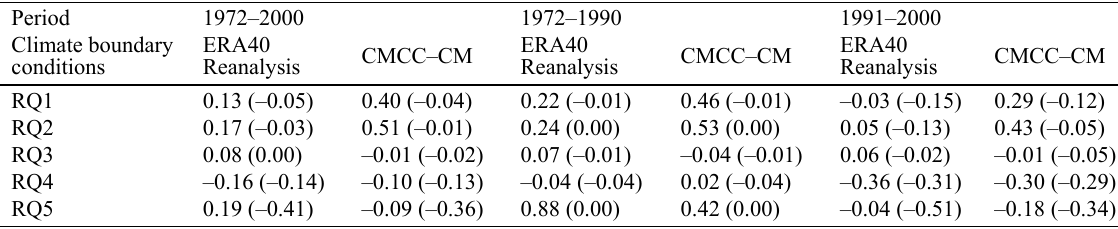
Fig. 2 Monthly average (a) areal precipitation and (b) discharge at Pontelagoscuro and (c) FDCs. In panel (c) only some of the points are indicated with the symbols. The simulations are labelled according to the climate data used to force them: observations, COSMO–CLM driven by ERA40 Reanalysis or COSMO–CLM driven by CMCC–CM. Table 1 Values of the RQ indices computed in the calibration (1972–1990), validation (1991–2000) and for the whole simulation period (1972–2000) for original discharge time series with respect to the simulation driven by the observed climate over the same periods. Values in brackets refer to corrected simulations. Simulations are identified by the climate boundary condition